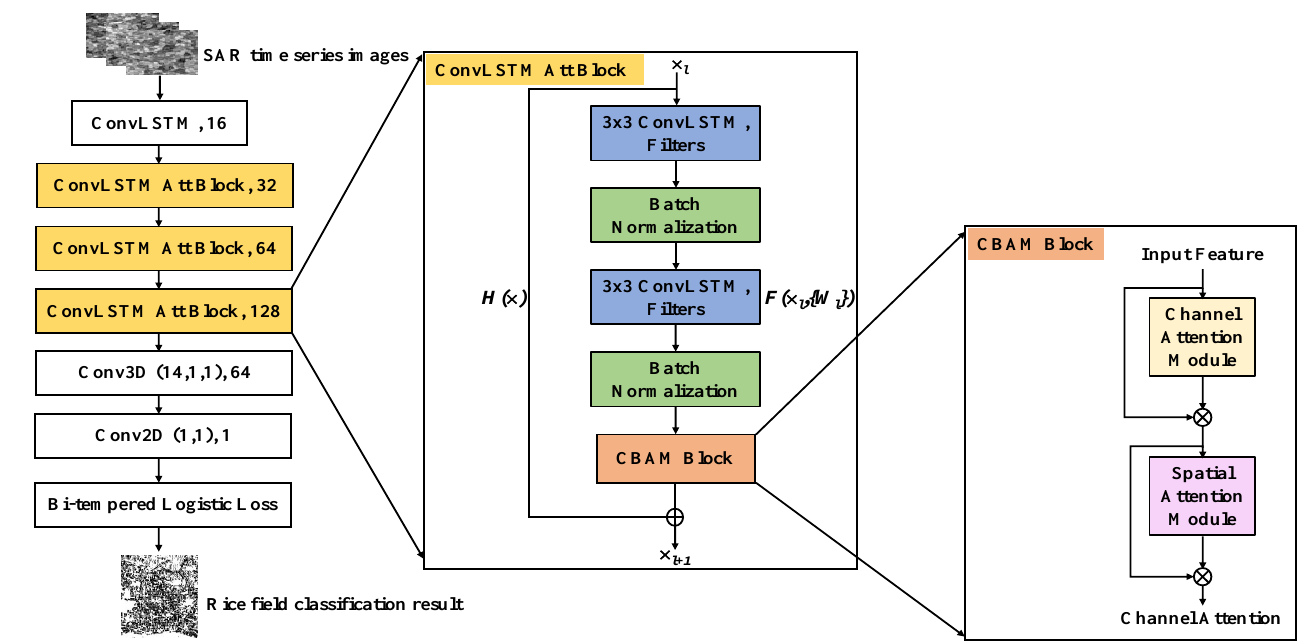
Figure 4. The architectural framework of the proposed